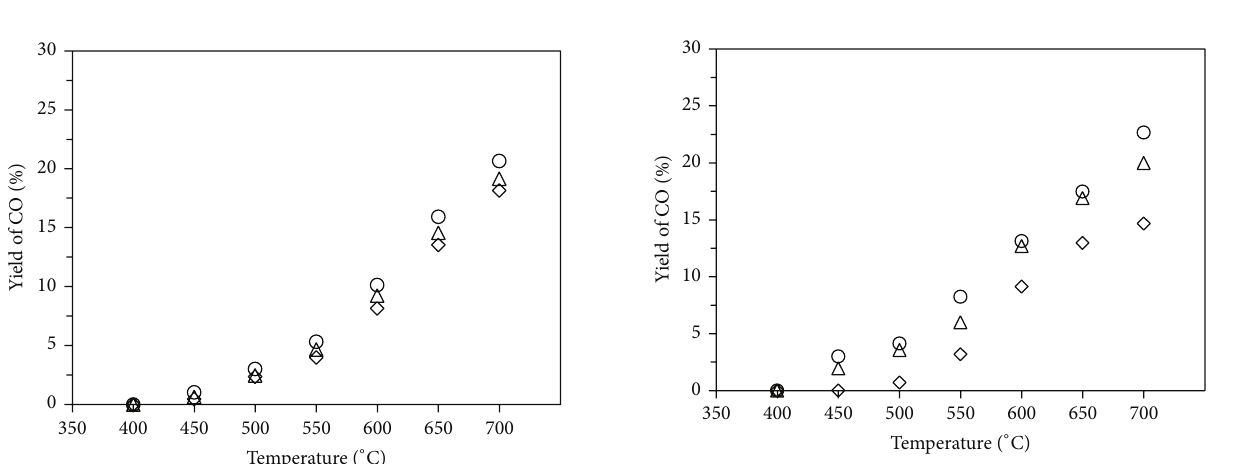
Figure 5: RWGS reaction at 1 atm, 𝑃 He, GHSV = 176000 h −1 , and 50 mg of catalyst: Cu 20 Ni 80 /C, 10wt%, where ⃝ = 1st cycle, △ = 2nd cycle, and ⬦ = 3rd cycle.